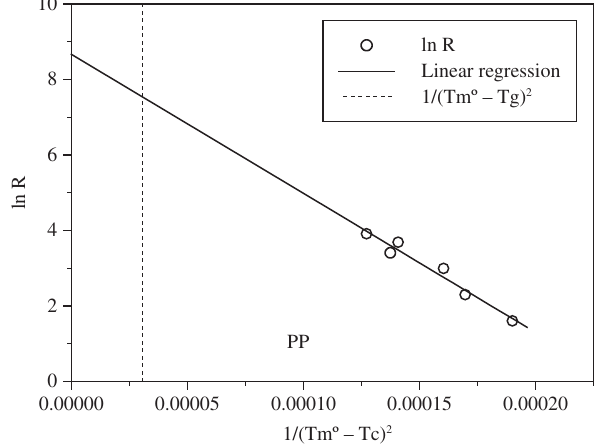
Figure 2. Fitting of the crystallization data to Equation 1 for obtaining the critical cooling rate for vitrification of PP. Dotted vertical line represents the undercooling associated to Tg.